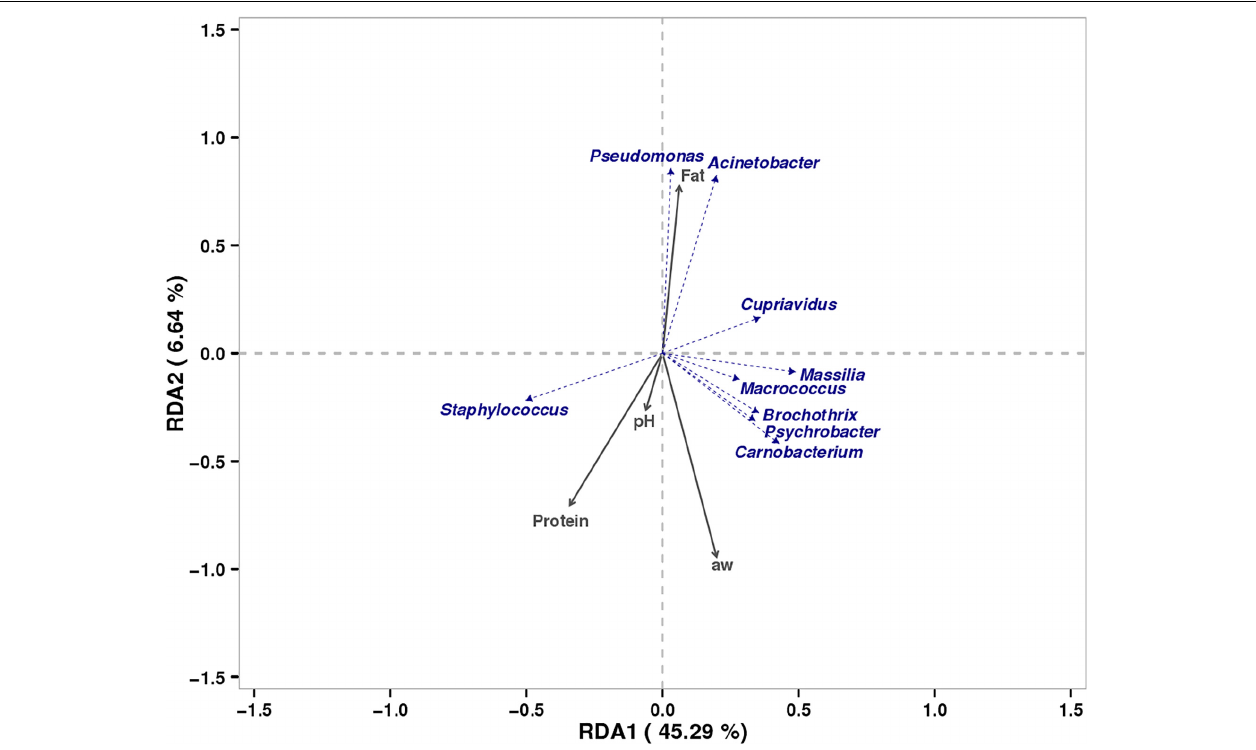
FIGURE 5 | RDA of dominant bacteria and physiochemical